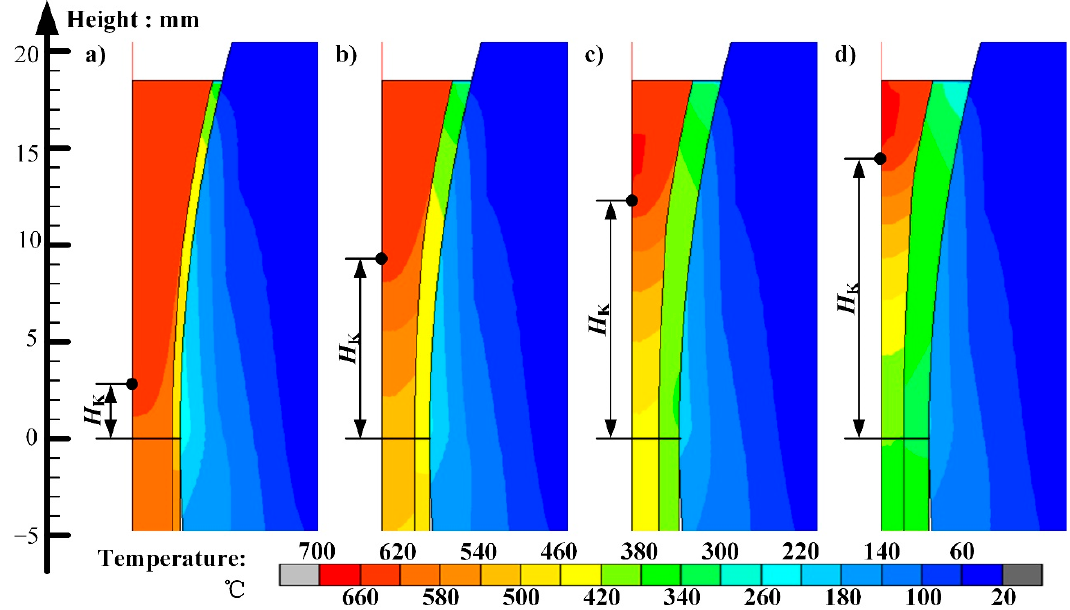
Figure 5. Contour bands of SLS-TRC temperature distribution with different clad thickness. ( a ) H 1060 = 0.5 mm; ( b ) H 1060 = 1.0 mm; ( c ) H 1060 = 1.5 mm; ( d ) H 1060 = 2.0 mm.